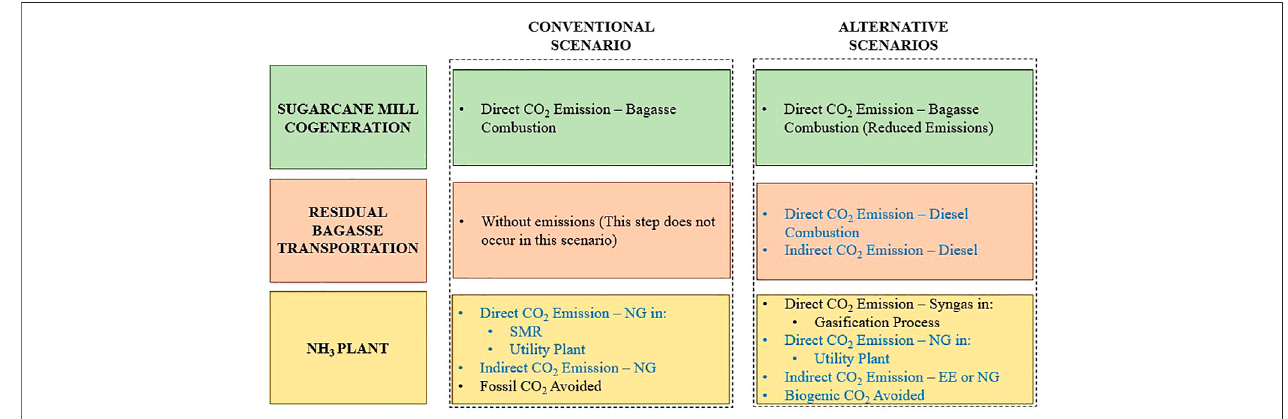
FIGURE 6 | Summary of the CO 2 emissions evaluated for the different control volumes presented in Figures 1 , 2 . The blue font color spotlights the emissions considered in the net CO 2 emissions balance.